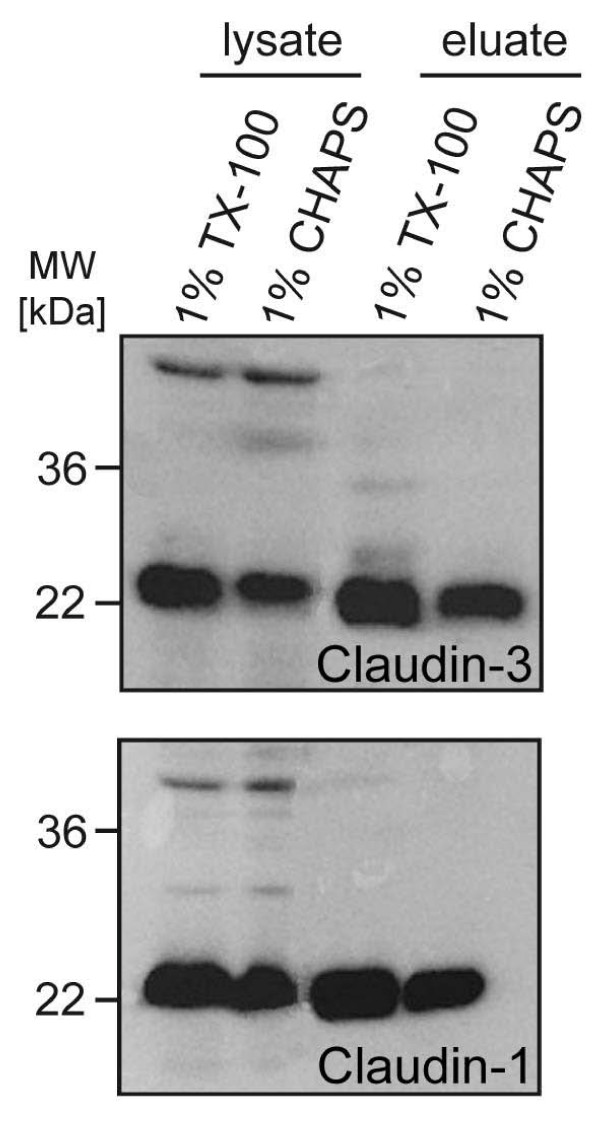
Solubilization of claudins by different detergents. Immunoblots against claudin-3 (upper panel) and claudin-1 (lower panel) of protein fractions from NRC cells (lysate and GST-CPE116–319eluate) solubilized by Triton X-100 or CHAPS.